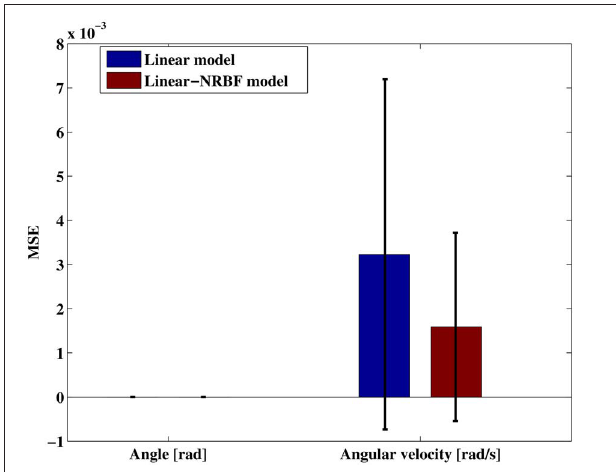
FIGURE 5 | Mean squared error of the joint angle and angular velocity. Each error bar represents the standard